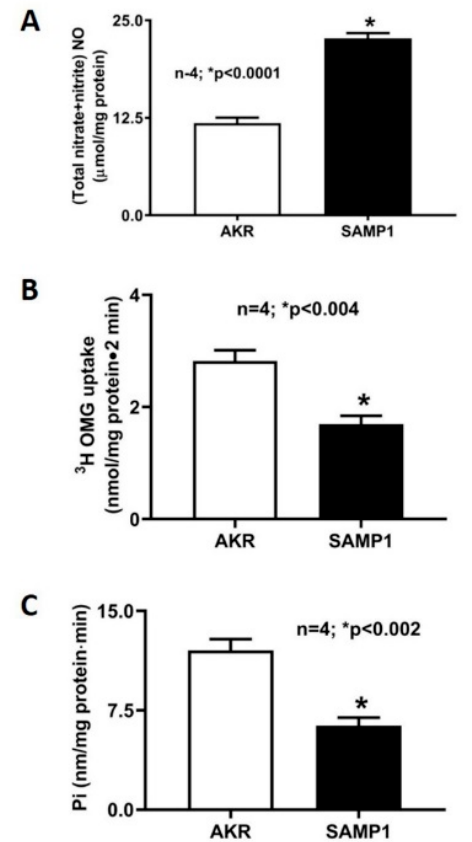
Figure 2. Physiological consequences of chronic intestinal inflammation in SAMP1 mouse. ( A ) Nitric oxide (NO): Mucosal levels of NO are significantly increased in SAMP1 mouse intestine. ( B ) Na- glucose co-transport (SGLT1): Na-dependent and phlorizin-sensitive 3 H-OMG uptake is significantly decreased in villus cells from the SAMP1 intestine. ( C ) Na + /K + -ATPase: The activity of Na + /K +